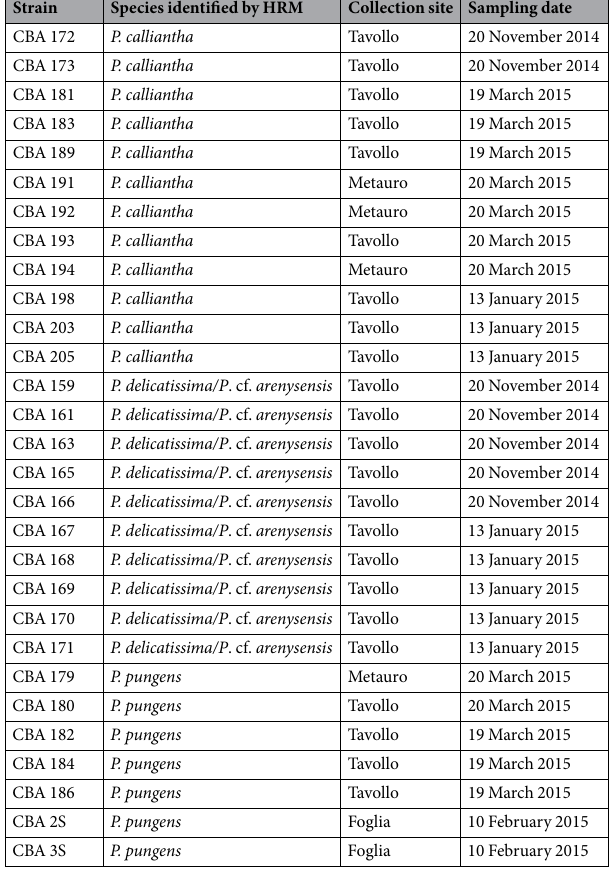
Table 1. List of Pseudo-nitzschia spp. strains isolated from the NW Adriatic Sea 3000 m off the coast. The strains were analyzed and subsequently identified using the HRM